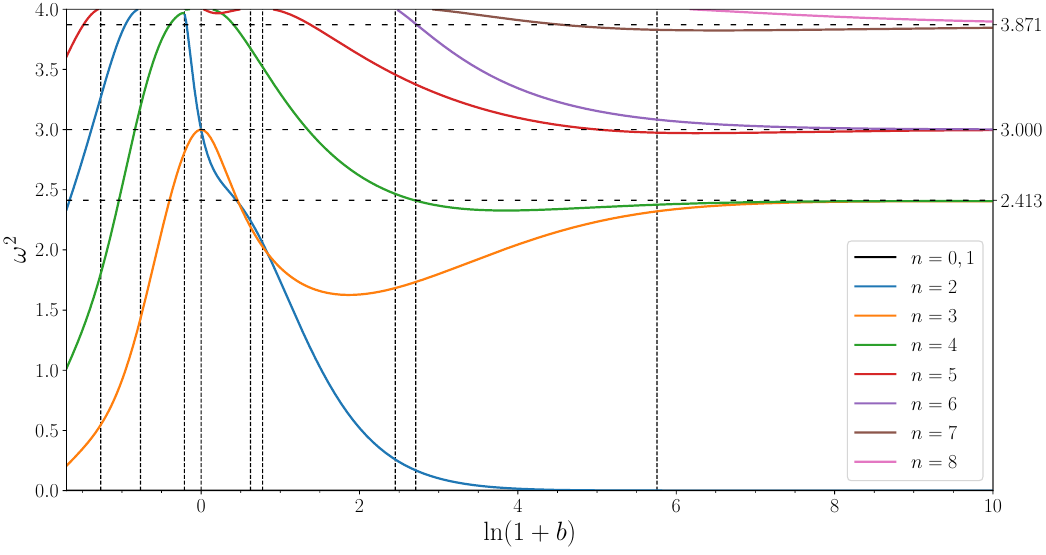
Figure 5 . The flow of the spectral structure on the moduli